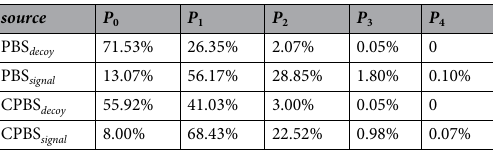
Table 3. Photon-blockade sources used in numerical simulations of QKD when κ = 10 GHz ( f = 2 GHz).